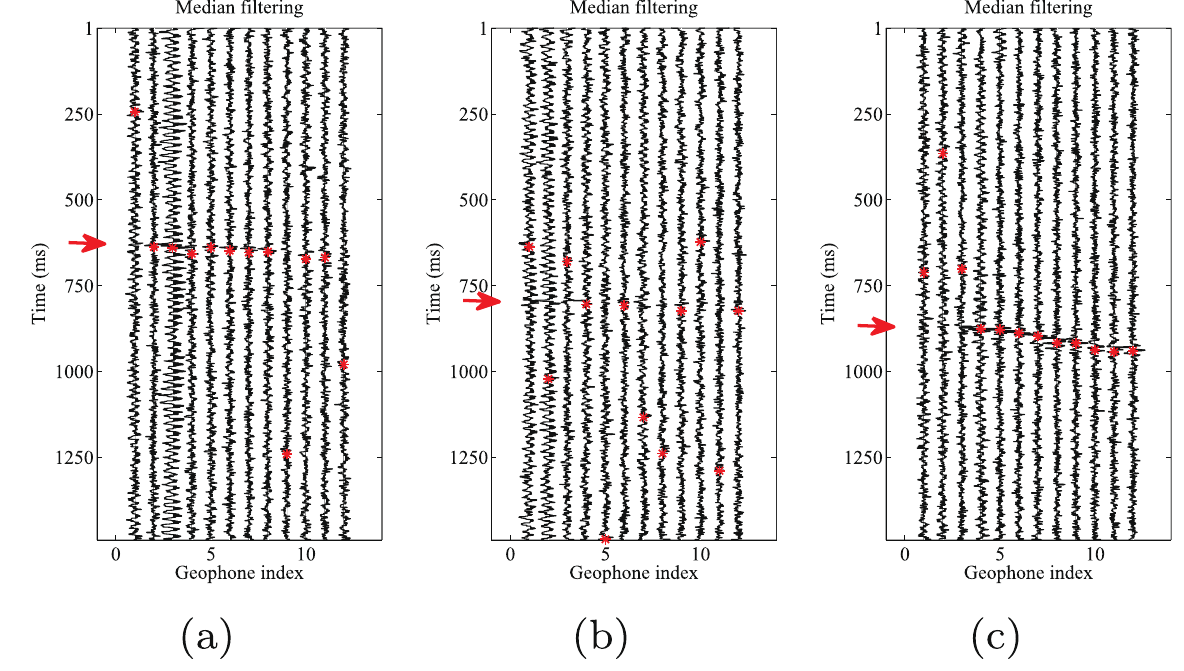
Figure 14. Arrival picking results using median filtering. ( a ) Horizontal component (H1). ( b ) horizontal component (H2). ( c ) Vertical component (V).